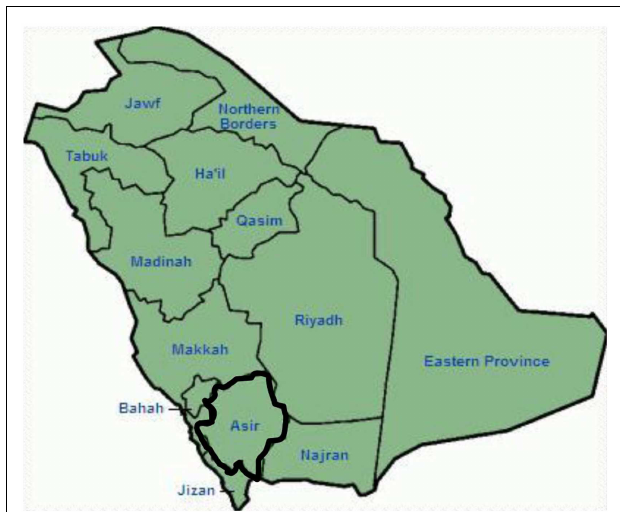
FIGURE 6 | Map of SaudiArabia (courtesy:Wikipedia) . Assir region is marked with thick line, where we have found the founder mutations in KCNQ1 and KCNH2 genes, described in family